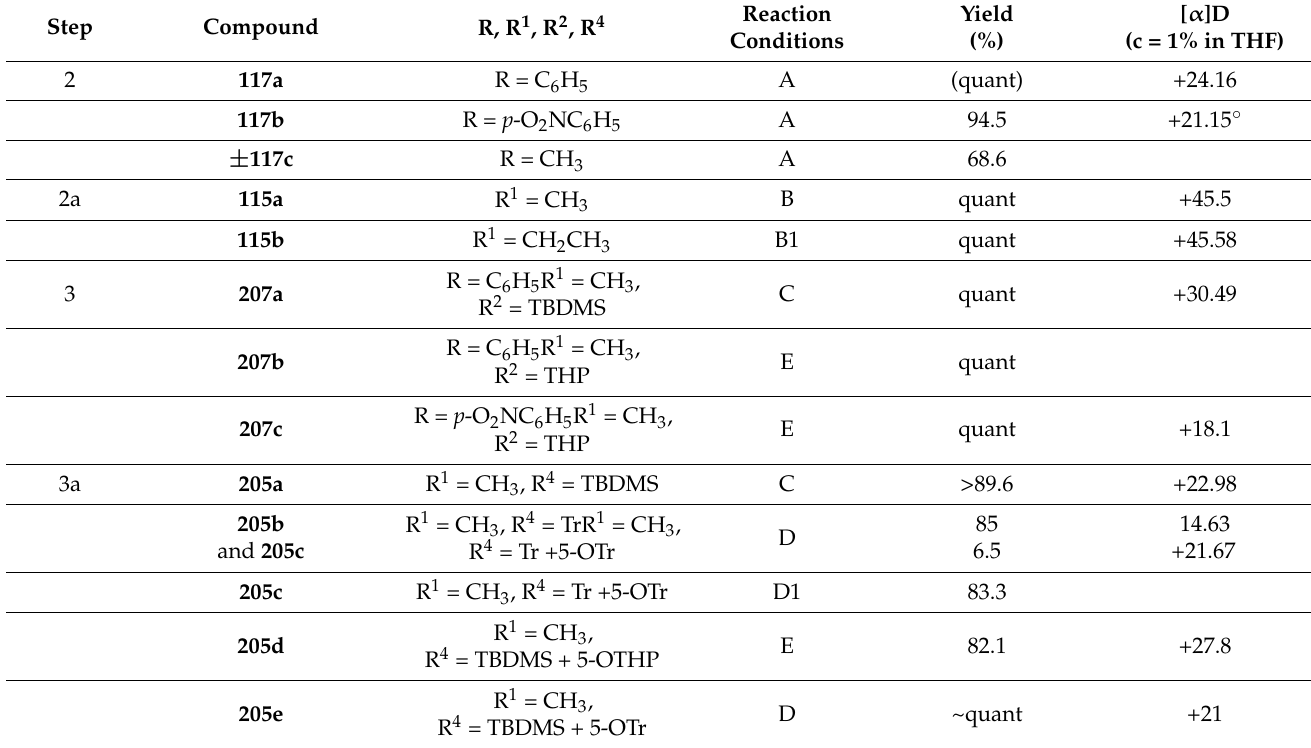
Table 4. 5 β -Chloro-cyclopentane intermediates obtained by acid alcoholysis of δ -lactones 114 and 116 .